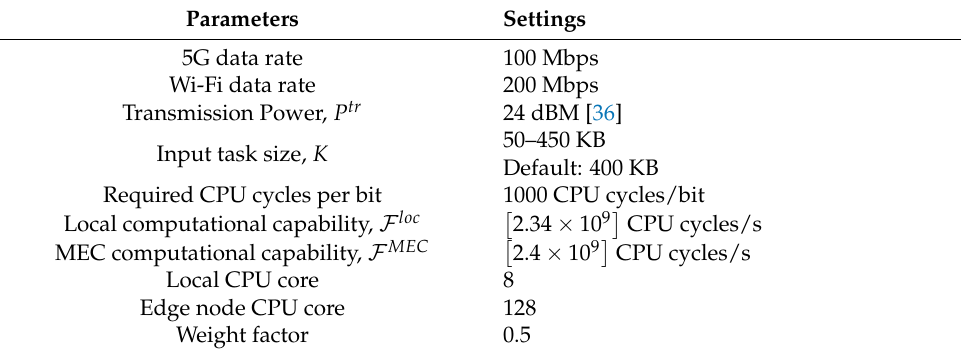
Table 2. Simulation Parameters.